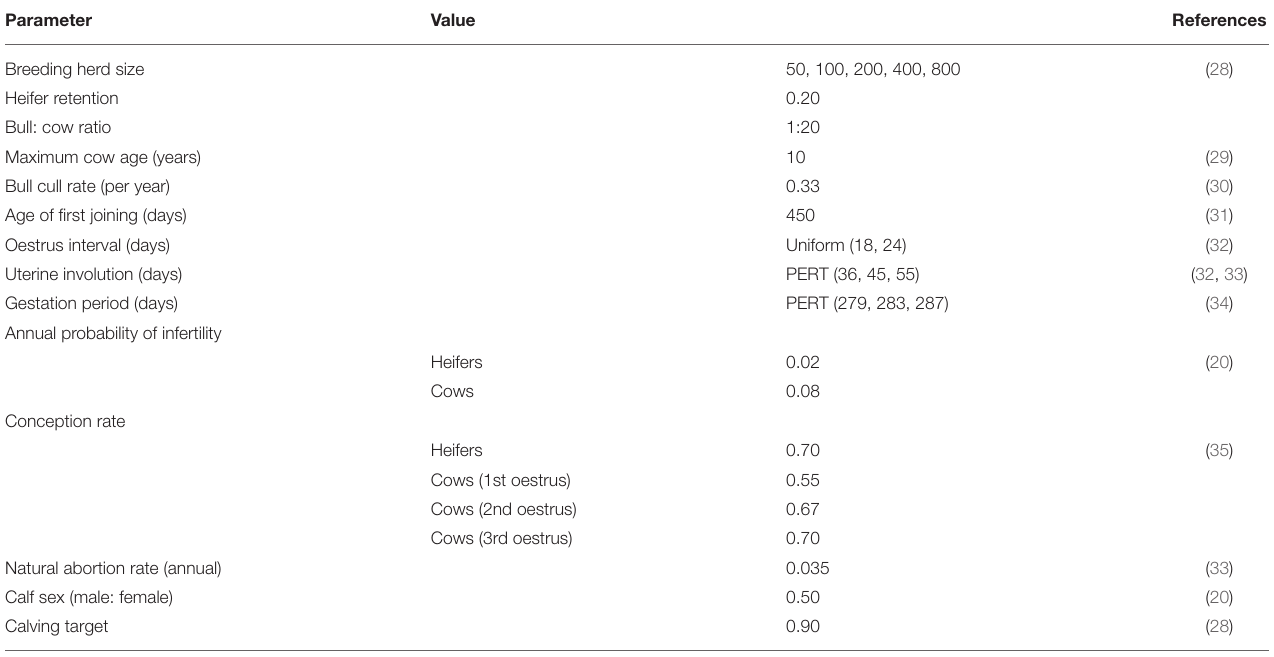
TABLE 1 | Parameters used to represent a self-replacing beef system in south-east Australia in a BVDV simulation model. Parameter